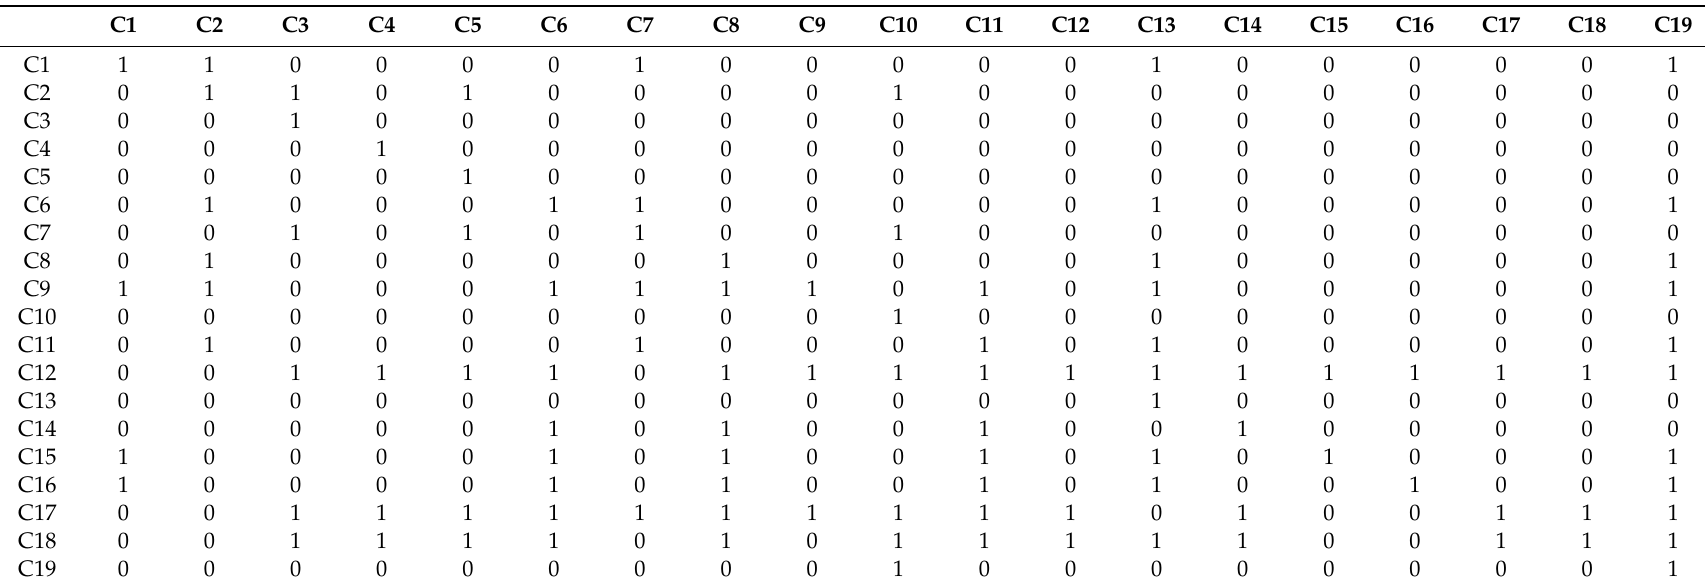
Table 7. Accessibility matrix